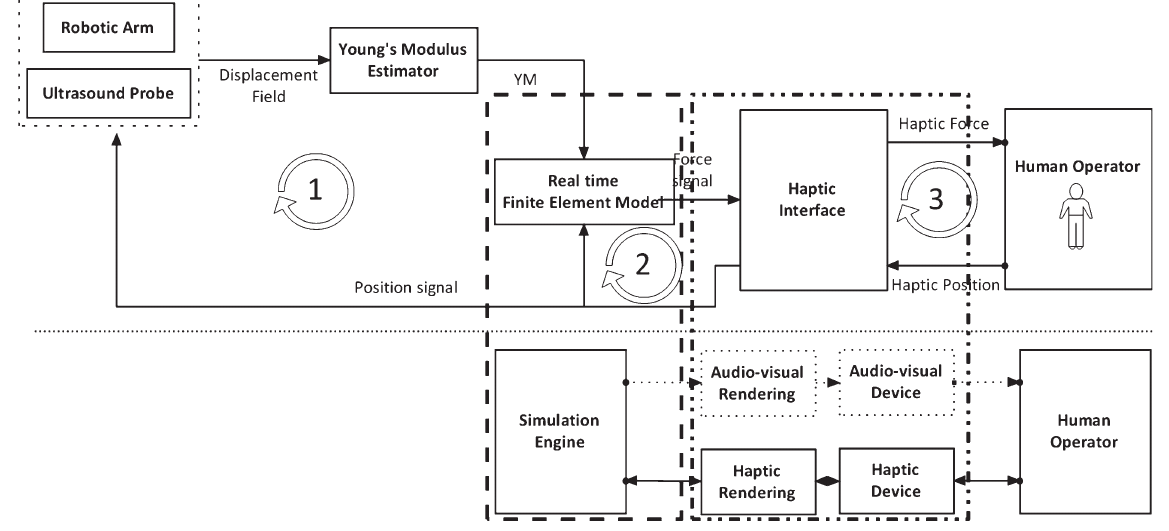
Fig. 7. Analogies between the scheme presented here and Salisbury’s